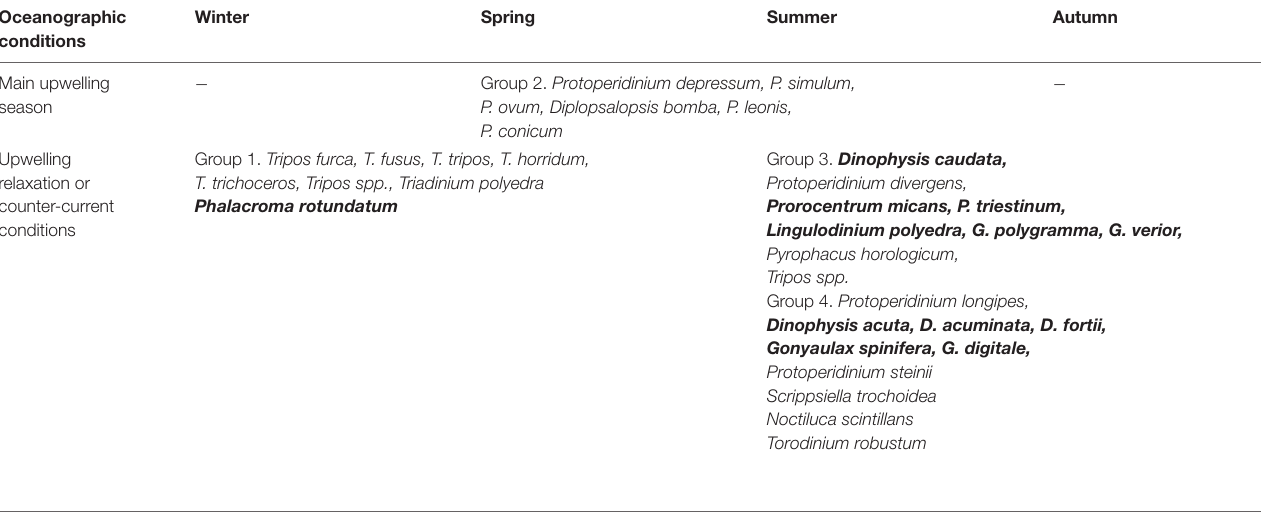
TABLE 5 | Dinoflagellate groups with dominant species and the seasonality of their appearance; potentially harmful species highlighted in bold. Oceanographic